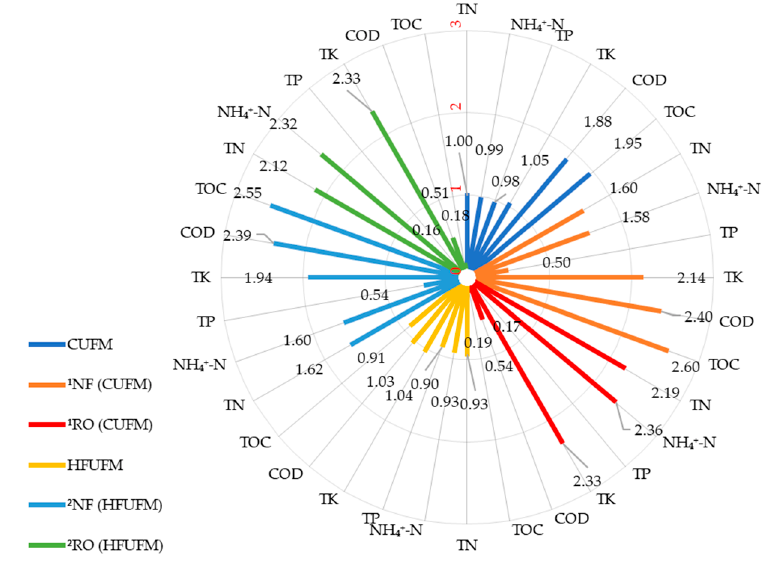
Figure 3. The average concentration factors of TN, NH 4+ -N, TP, TK, COD, and TOC in the concentrates of the integrated process with HFUFM and CUFM pretreatments. Note: 1 NF (CUFM), 1 RO (CUFM), and 2 NF (HFUFM), 2 RO (HFUFM) means NF concentrate, RO concentrate with CUFM pretreatment, and NF concentrate, RO concentrate with HFUFM pretreatment, respectively.